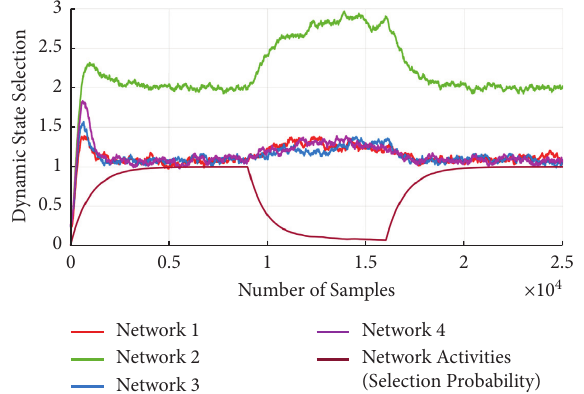
Figure 18: Effect of threshold on network connectivity for threshold � 2 ( S l � 5).